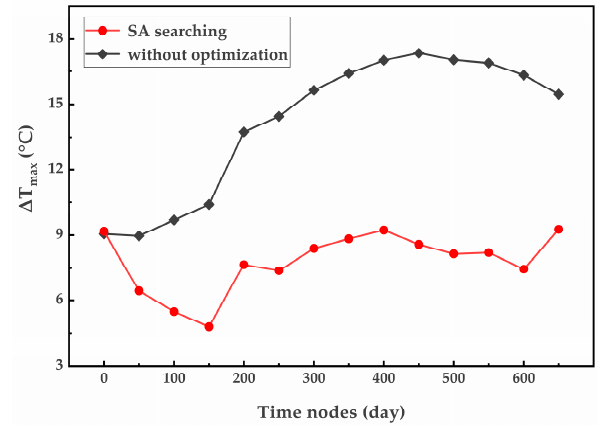
Figure 5. Outlet coolant temperature difference during single fuel life cycle.